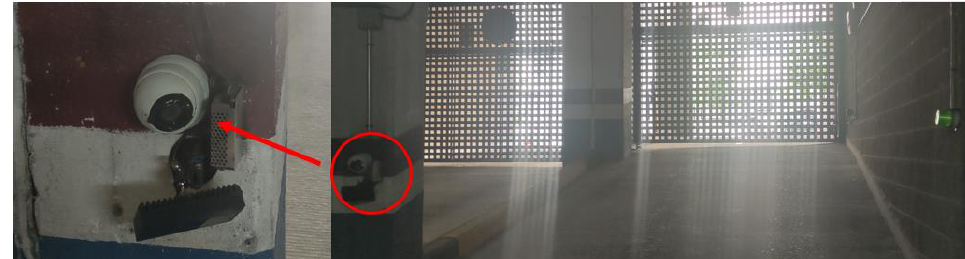
Figure 1. Example of an access control camera for license plate reading [8].